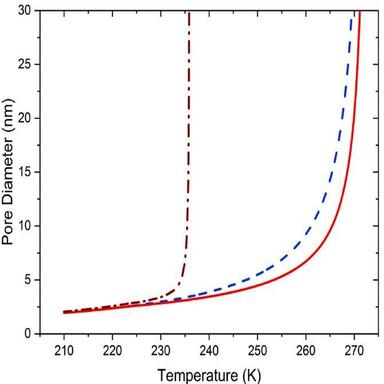
Critical pore diameters corresponding with the pores where phase transitions occur at the given temperature, as a function of temperature for different transitions: melting and freezing at equilibrium pore temperature (broken blue line, xeq vs. T), nucleation-facilitated melting (red solid line, xml vs. T), and freezing by homogeneous ice nucleation (dotted brown line, xeq vs. T). (For interpretation of the references to colour in this figure legend, the reader is referred to the Web version of this article